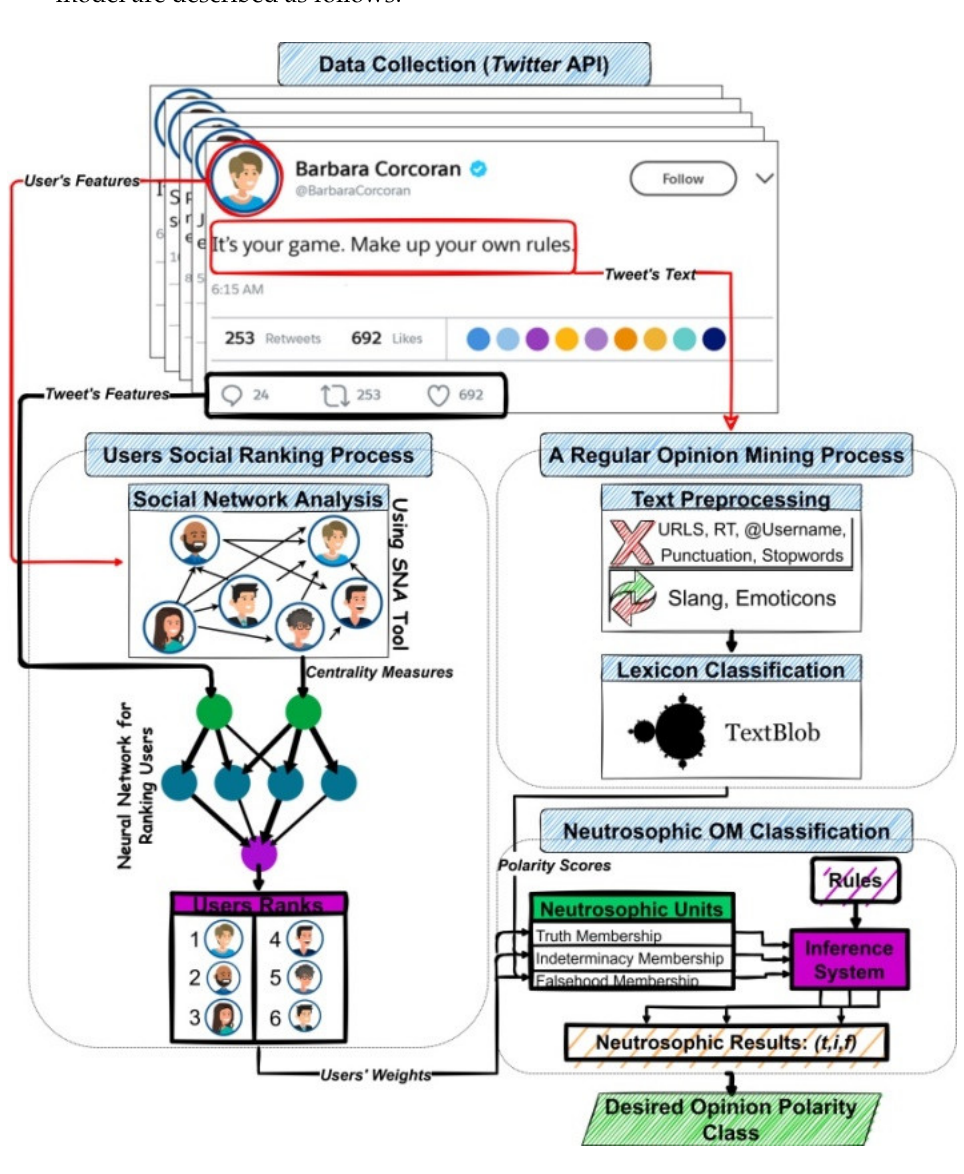
Figure 2. The proposed NL-based OM model.